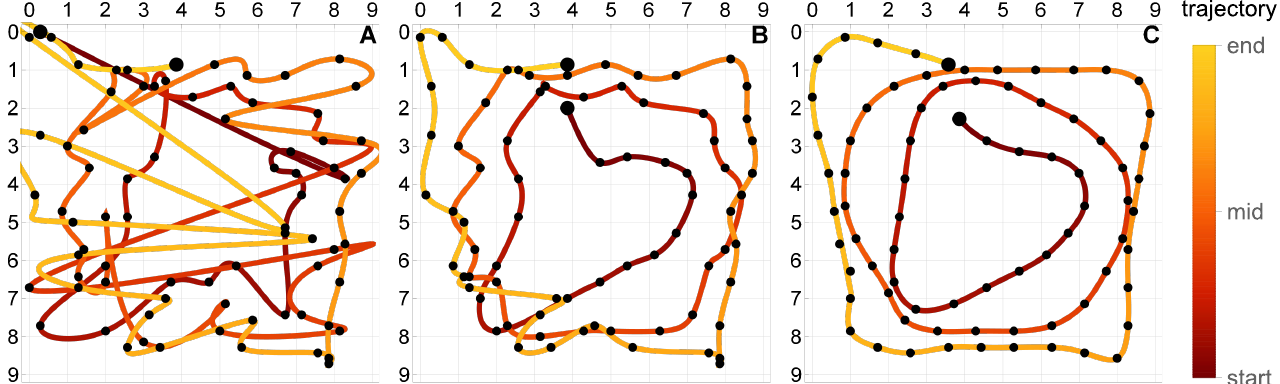
Figure 14. Identification of the compound triple trajectory shown in Figure 12a. The trajectories A, B and C correspond to the three points marked on the respective Pareto front in Figure 13.